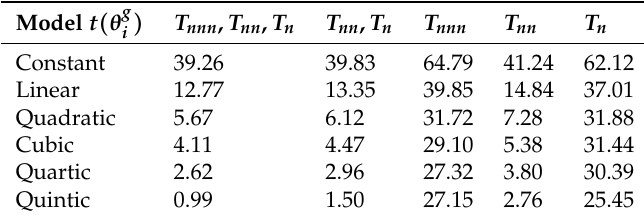
Table 1. Cost function residuals for the different T g